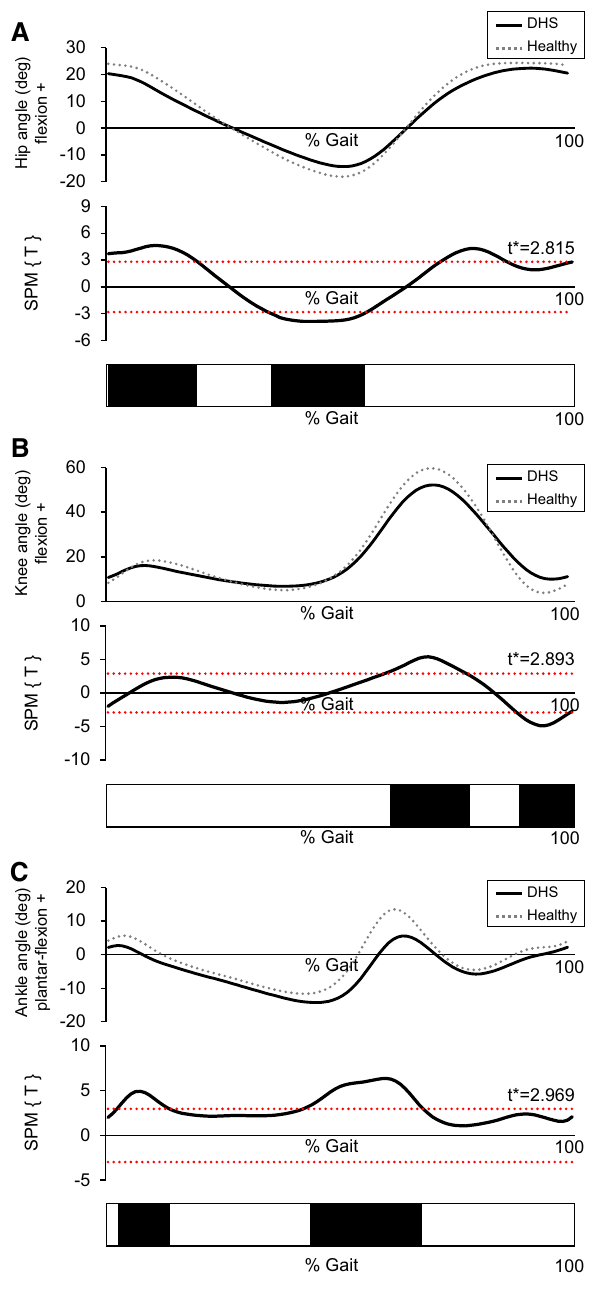
Figure 2. The whole gait cycle waveforms of kinematics in both groups. ( A ) Hip joint angle, ( B ) knee joint angle, and ( C ) ankle joint angle. t* indicate the critical threshold. Lower black bars represent a simplified visualization of the significant areas indicated by the SPM{t} statistic. DHS Dropped head